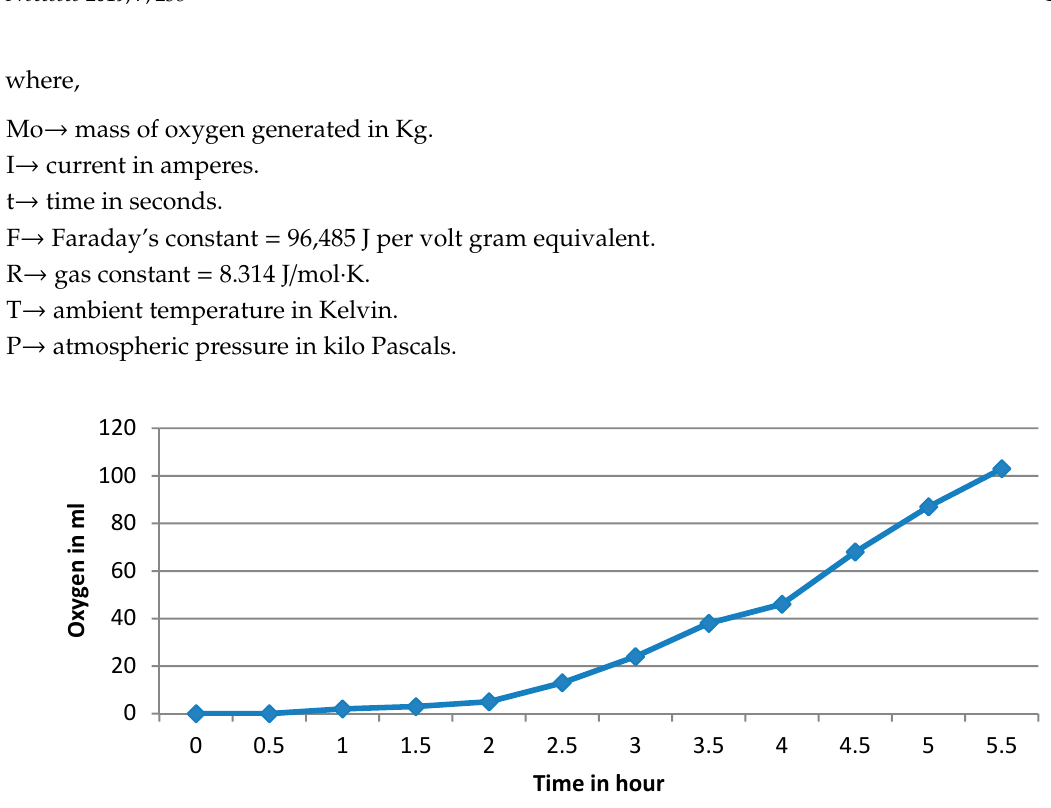
Figure 14. Graph showing relation between oxygen gas produced with respect to time in case of charging of proton battery. Table 9. X and Y axis variable values of the active points shown in Figure 14.